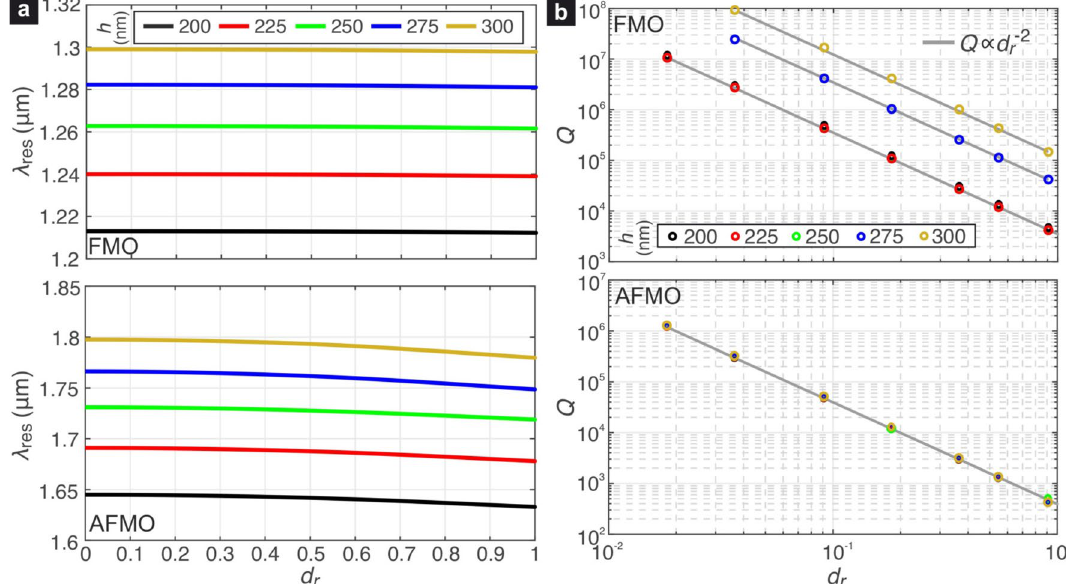
Figure 4. ( a ) Resonant wavelengths of the FMO/AFMO quasi-dark modes as a function of the relative displacement d r and for various values of the Si layer thickness h . ( b ) Quality factors of the FMO/AFMO for the same set of parameters as in ( a ). The Q values follow the Q ∝ d − 2 r law, characteristic of quasi-dark resonances in symmetry-broken